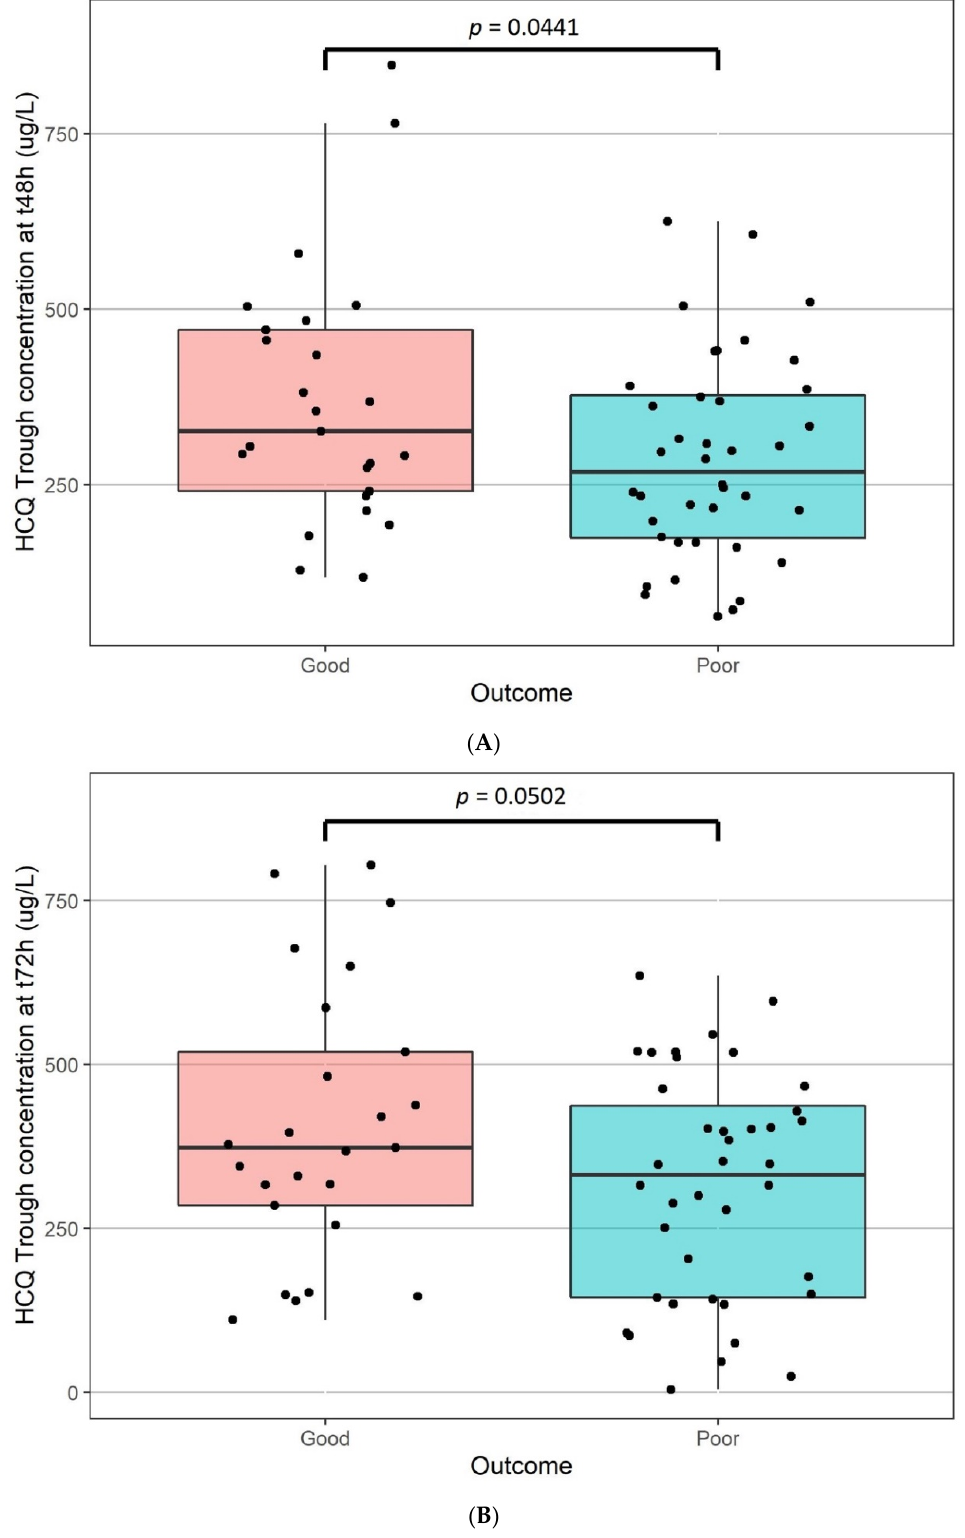
Figure 6. Clinical outcome versus HCQ blood trough concentrations at t48 h ( A ) and t72 h ( B ). The empirical cumulative distribution function of the length of stay was plotted for different HCQ trough concentration ranges: 0–200 µ g/L, 200–400 µ g/L, 400–600 µ g/L, 600–800 µ g/L, and above. Figure 7A,B depicts the results at 48 h and 72 h,